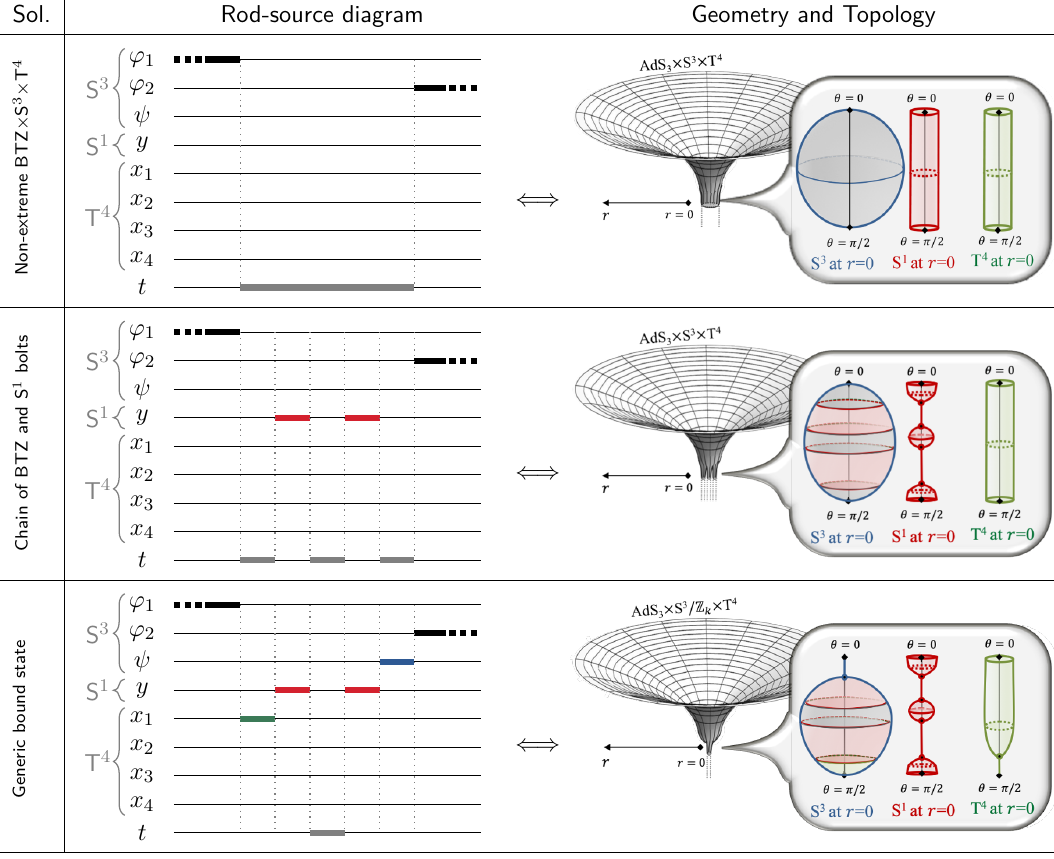
Table 2 . Description of the axially-symmetric static non-extremal BTZ bound states constructed in this paper. We used the same conventions as in table